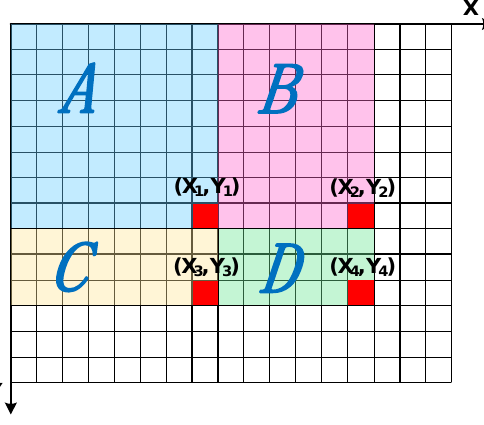
Figure 5. The principle of the integral image. Adaptive threshold segmentation is realized by comparing the gray value of a pixel p i ( x i , y i ) (see Figure 6) with the average gray value of pixels lying in its surrounding rectangular area (yellow area in Figure 6). If the gray value of the pixel is greater than the average gray value of its surrounding pixels, it can be considered as the foreground pixel, otherwise it is considered as the background pixel. Suppose that parameter 𝑠 (see Figure 6) and parameter 𝑡 (the value of t is greater than 0 and less than 1) represents the background radius and the segmentation coefficient, respectively; then, the sum of pixel gray values in the rectangular area with 𝑃 𝑖 as the cen- ter and 2𝑠 + 1 as the side length is determined by Equation (18).